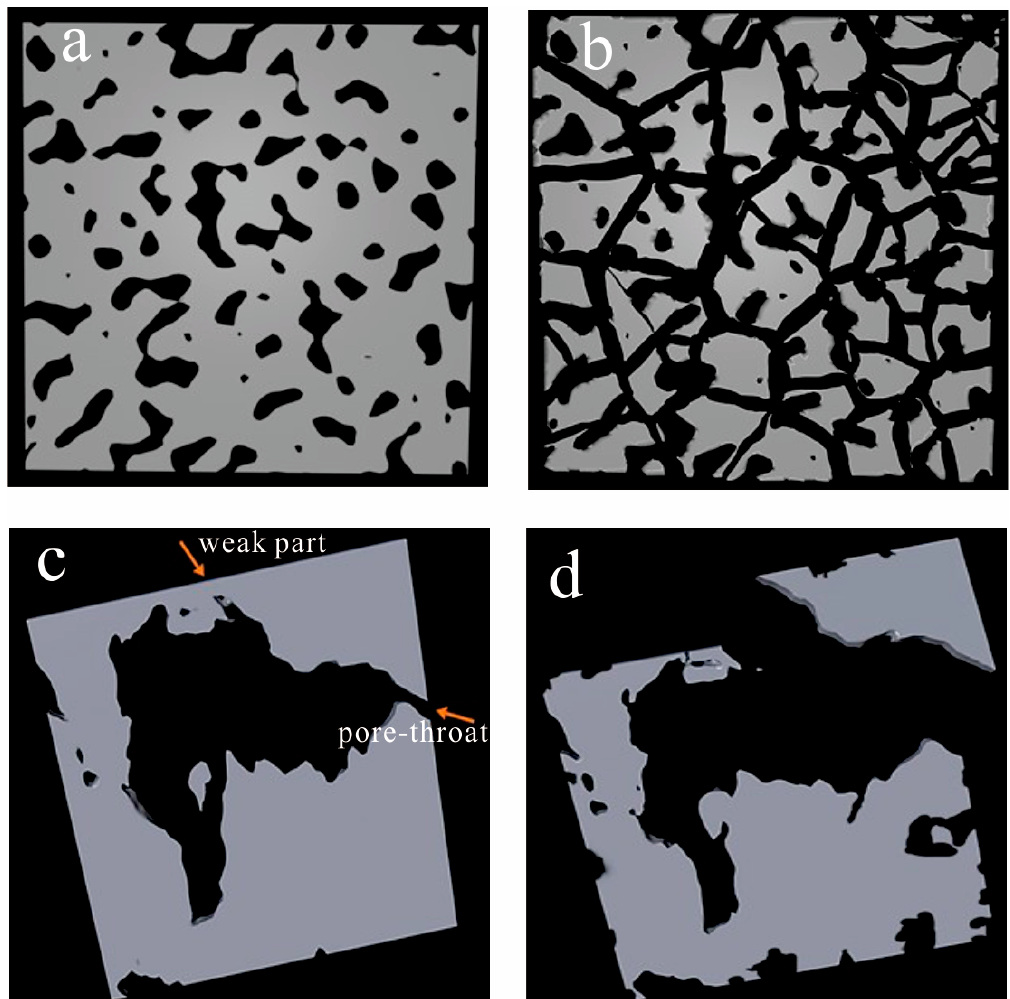
Figure 10. Model of an intact shale and a particle shale ( a , c ) before and ( b , d ) after crushing (the gray areas denote the shale solid matrix, and the black areas denote pores or fractures space).